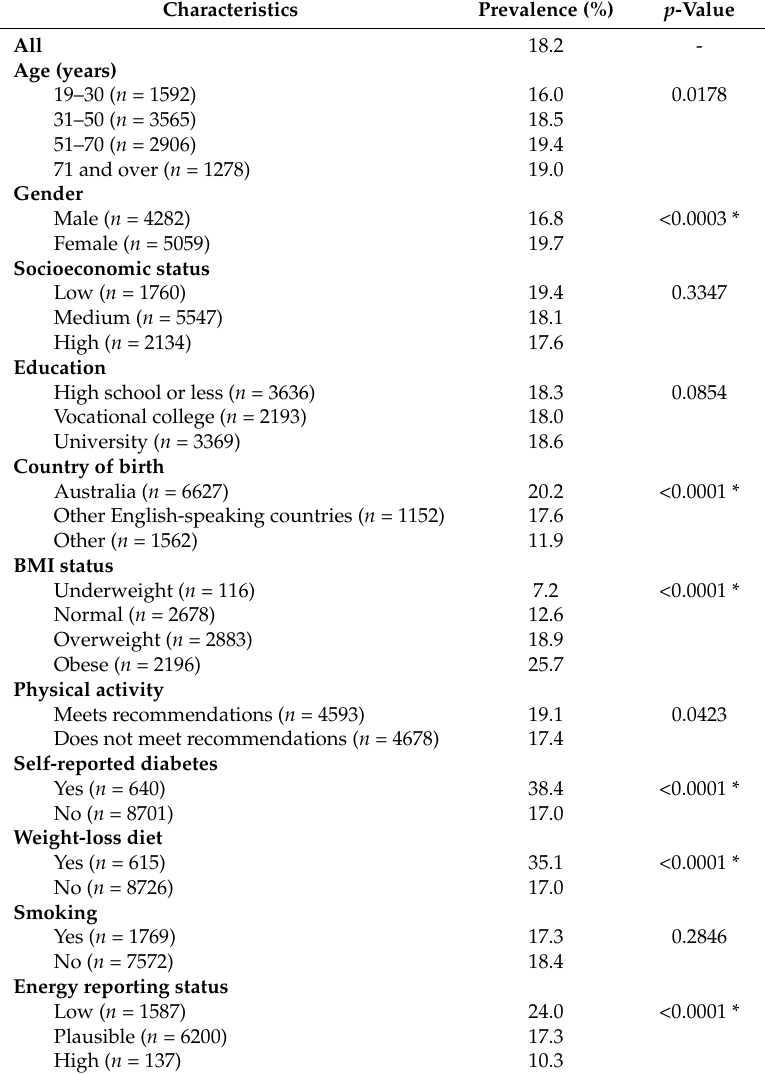
Table 2. Prevalence of non-nutritive sweetener consumption per day of Australian adults aged 19 years and